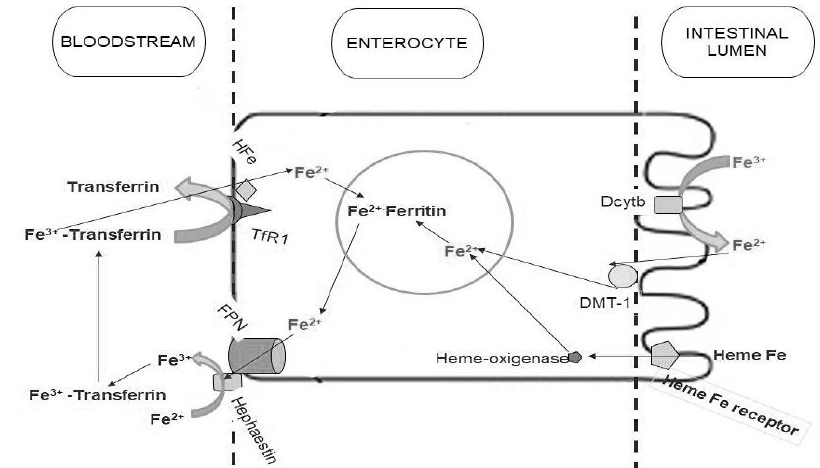
Figure 1. Iron absorption metabolism. Non-heme iron is ultimately taken up from the lumen by divalent metal transporter (DMT-1) on the microvillus membrane, before joining the labile iron pool in the cell. Ferric iron has to be reduced to the ferrous form by duodenal cytochrome b (Dcytb) before the uptake. Ferrous iron in the labile iron pool is then transferred to the circulation by ferroportin (FPN), which requires hephaestin for oxidation to the ferric form to bind transferrin. Heme iron is taken up by a specific receptor. Internalized heme iron is degraded by heme-oxygenase, releasing non-heme iron. The non-heme iron is then transported to the cytoplasm, joining the labile iron pool and is then transferred to the bloodstream by FPN in the same manner as non-heme iron.